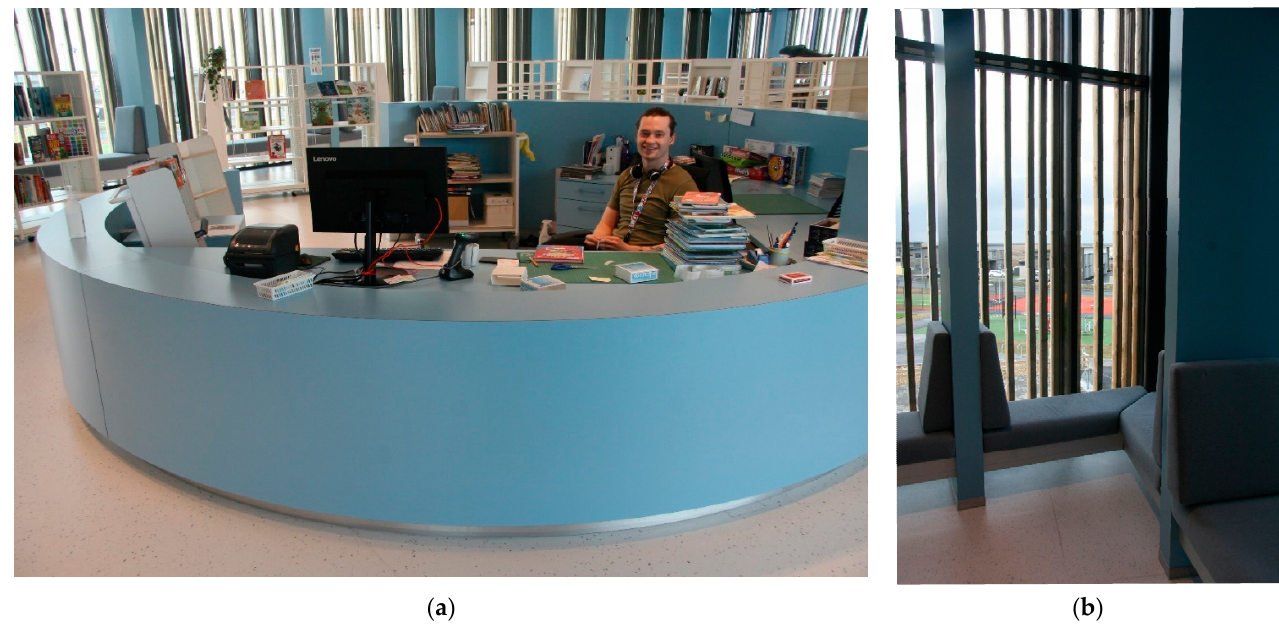
Figure 10. The library. ( a ) An oval reception desk resides in spacious facilities filled with light. The school is new, and many shelves are still empty. ( b ) Upholstered benches run along the walls. Wooden bars on the outside forming a striped pattern can also be detected.